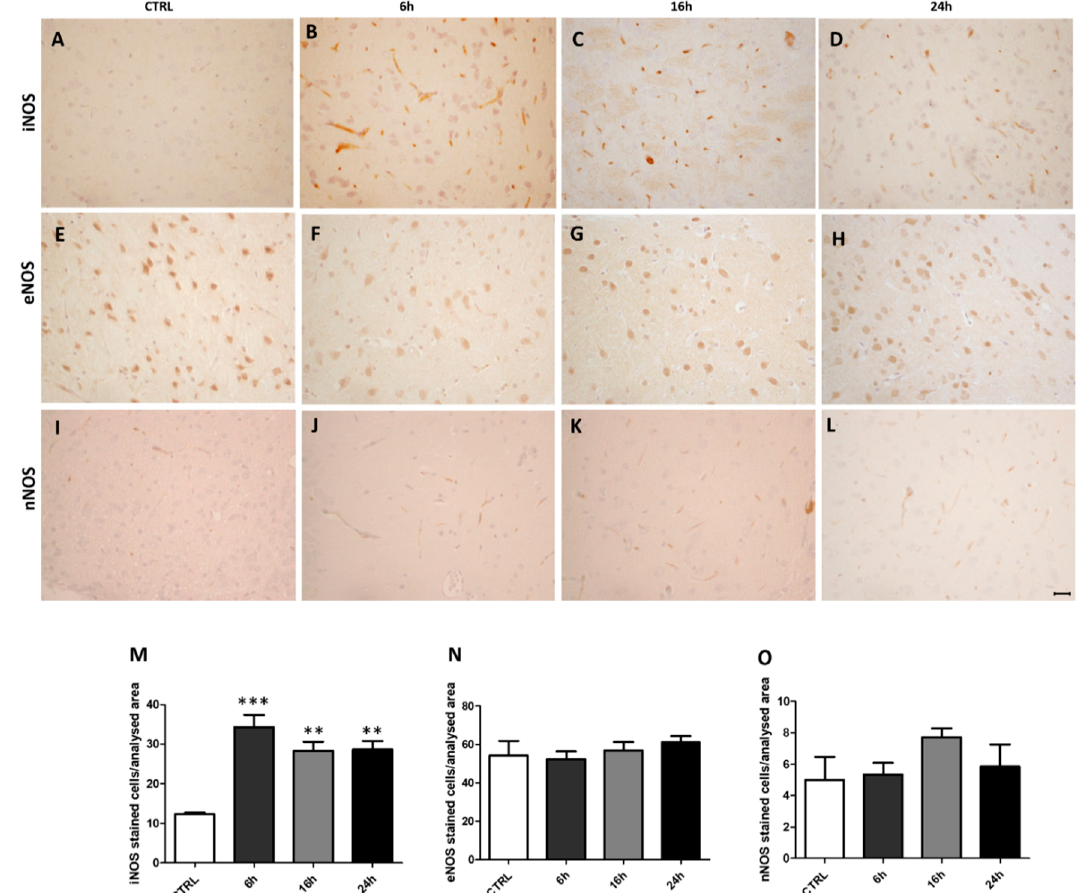
Figure 2. Inducible nitric oxide synthase (iNOS) immunoreactivity is increased following MDMA administration. ( A – D ) Representative images (light microscopy, 40×) of iNOS immunoreactivity in the frontal cortex of rats receiving ( A ) saline (CTRL) and of rats receiving MDMA and sacrificed after ( B ) 6 h, ( C ) 16 h, and ( D ) 24 h from its administration. ( E – H ) Representative images (light microscopy, 40×) of endothelial nitric oxide synthase ( eNOS) immunoreactivity in the frontal cortex of rats receiving ( E ) saline (CTRL) and of rats receiving MDMA and sacrificed after ( F ) 6 h, ( G ) 16 h, and ( H ) 24 h from its administration. ( I – L ) Representative images (light microscopy, 40×) of neuronal nitric oxide synthase ( nNOS) immunoreactivity in the frontal cortex of rats receiving ( I ) saline (CTRL) and of rats receiving MDMA and sacrificed after ( J ) 6 h, ( K ) 16 h, and ( L ) 24 h from its administration. Scale bar for images in panels ( A – L ) =50 μ m. ( M – O ) Quantification of ( M ) iNOS, ( N ) eNOS, and ( O ) nNOS positive-stained cells/area analyzed in controls (CTRL) and MDMA-exposed rats, sacrificed after 6 h, 16 h, and 24 h from its administration. One-way ANOVA followed by Tukey’s post-hoc test. For iNOS: F = 9.090, *** p < 0.001 6 h vs. CTRL, ** p < 0.01 16 h vs. CTRL and 24 h vs. CTRL, p ˃ 0.05 6 h vs. 16 h, 6 h vs. 24 h, and 16 h vs. 24 h; for eNOS: F = 0.7276, p ˃ 0.05; for nNOS: F = 1.290, p ˃ 0.05.